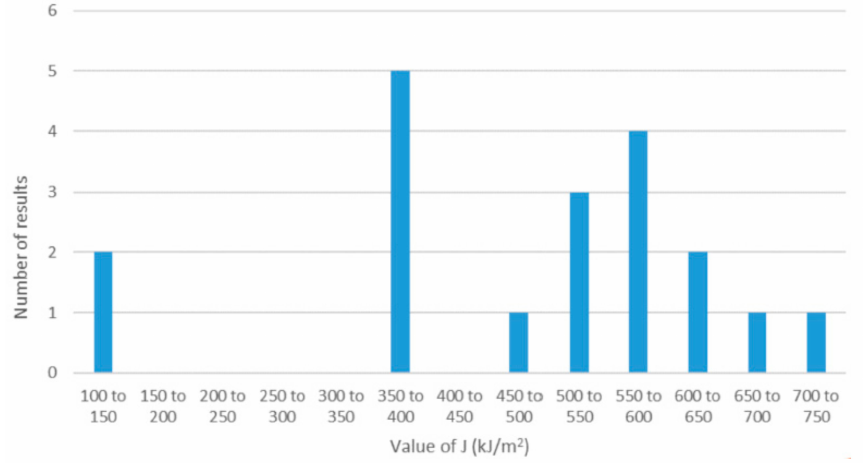
Figure 13. Frequency distribution of the valid fracture toughness results from the quasi-static SENB specimens notched to sample the weld fusion line, showing the range and